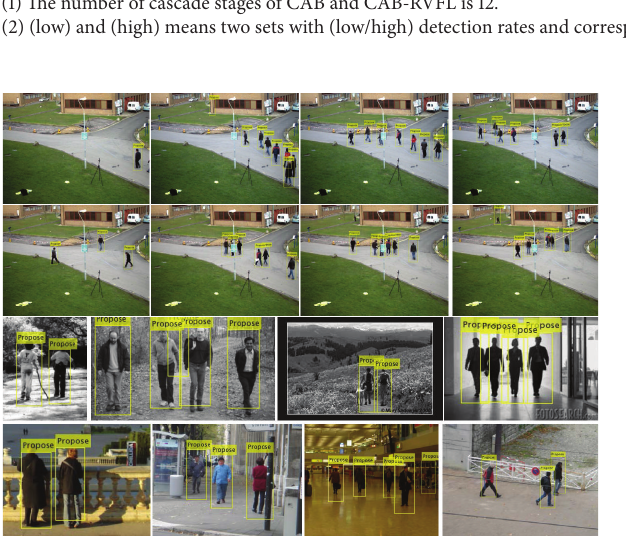
Figure 5: Examples of the four datasets. The first row is four samples of “Multiple Flow” dataset and the second row is “City Center” dataset. For demonstrated samples of these two datasets, each dataset has one pedestrian undetected due to the issue of heavy occlusion. The third row is USC(A) dataset and one false pedestrian is classified to be true positive target in the second subimage. The last row is INRIA dataset and all of the pedestrians are identified by the proposed system without any false